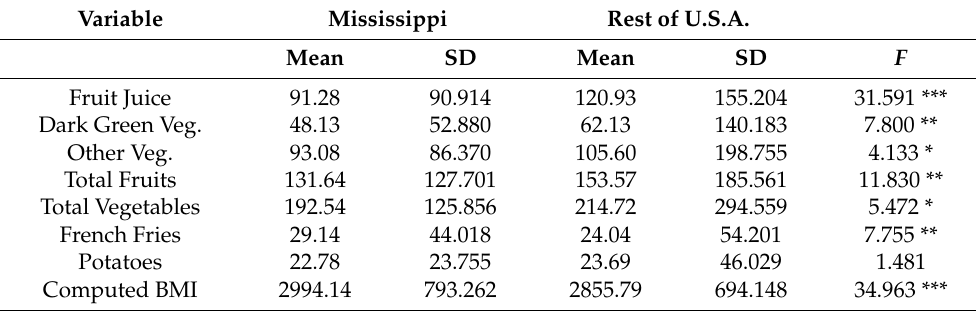
Figure 6. National Mean Computed Body Mass Index. Table 3. Descriptive Statistics and One-Way ANCOVA Results Comparing Mississippi to the Rest of the Nation, Adjusting for Age, Income, Race, Education, and Presence of Children in the Home. Variable Mississippi Rest of U.S.A. Mean 91.28 Dark Green